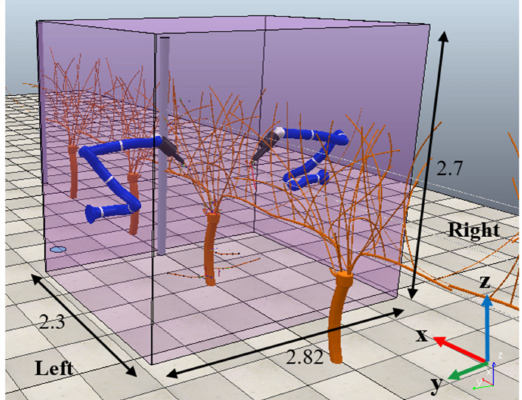
Figure 11. The task space of a grapevine-pruning robotic system with Prubot manipulators (lengths are in